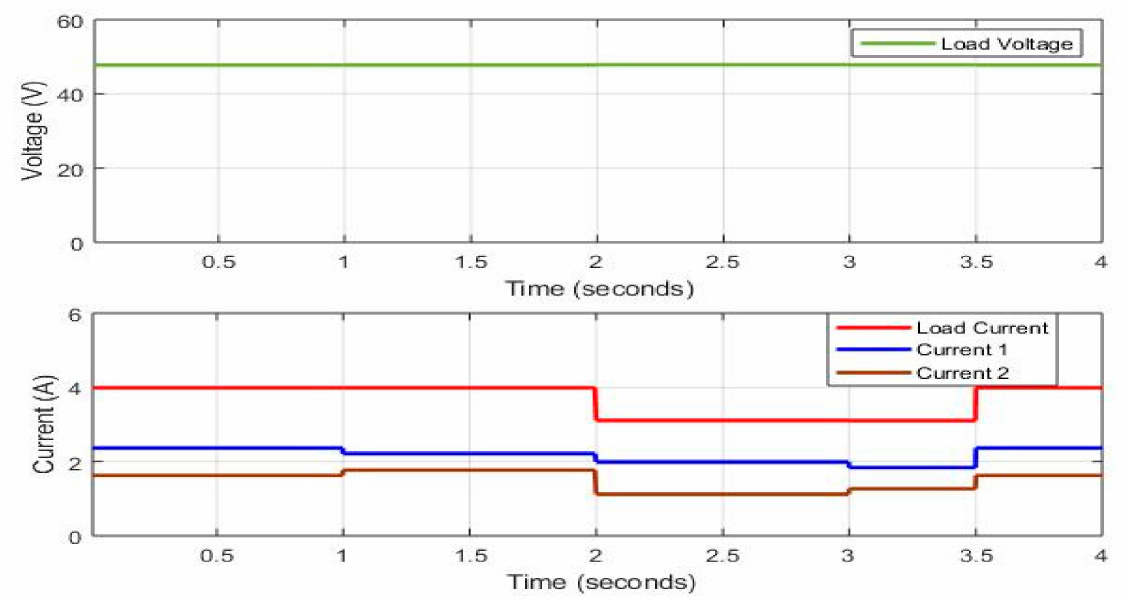
Figure 8. Simulation results for variation in source voltage and load with different cable resistances without any droop control: load voltage, converter output currents and load current.